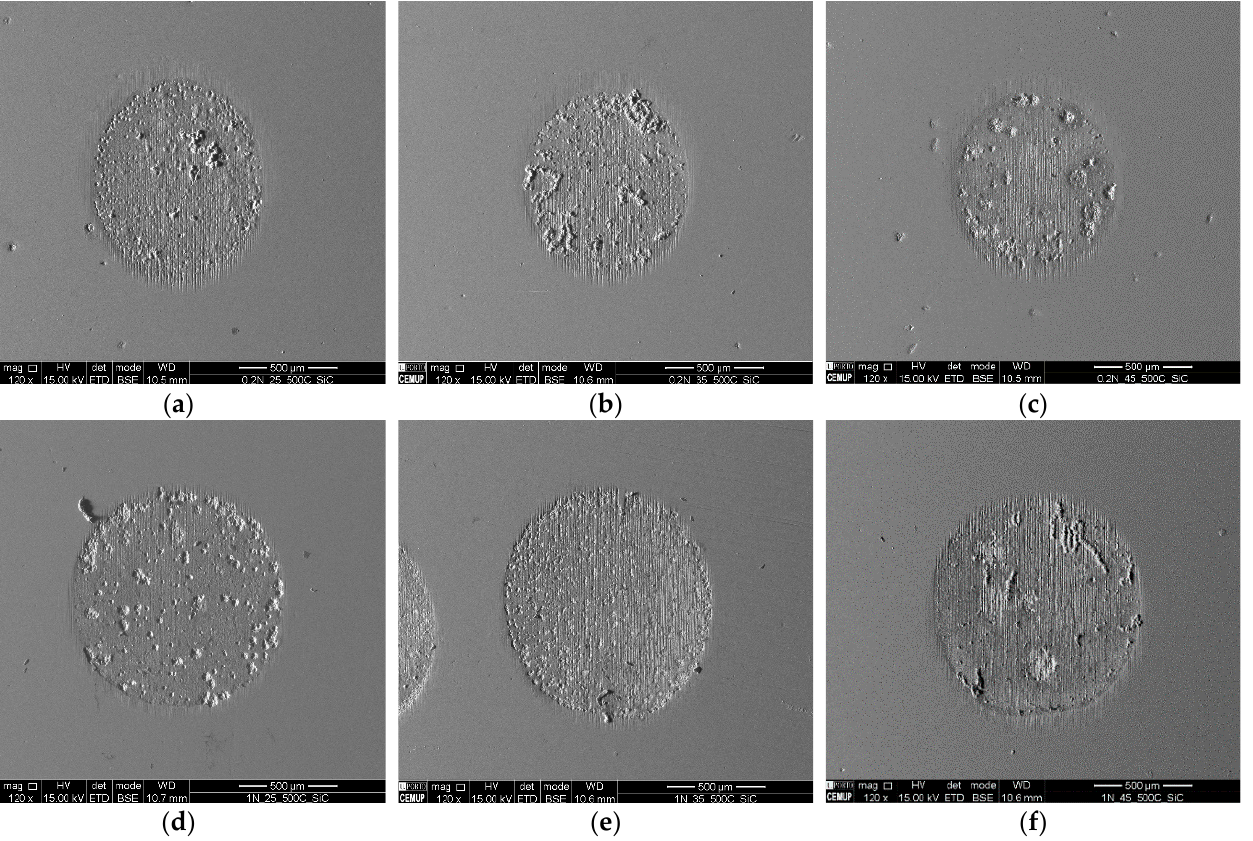
Figure 13. SEM images of the craters: ( a ) Load 0.2 N, (SC) 0.25 g/cm 3 ; ( b ) Load 0.2 N (SC) 0.35 g/cm 3 ; ( c ) Load 0.2 N (SC) 0.45 g/cm 3 ; ( d ) Load 1N, (SC) 0.25 g/cm 3 ; ( e ) Load 1 N (SC) 0.35 g/cm 3 ; and ( f ) Load 1 N (SC) 0.45 g/cm 3